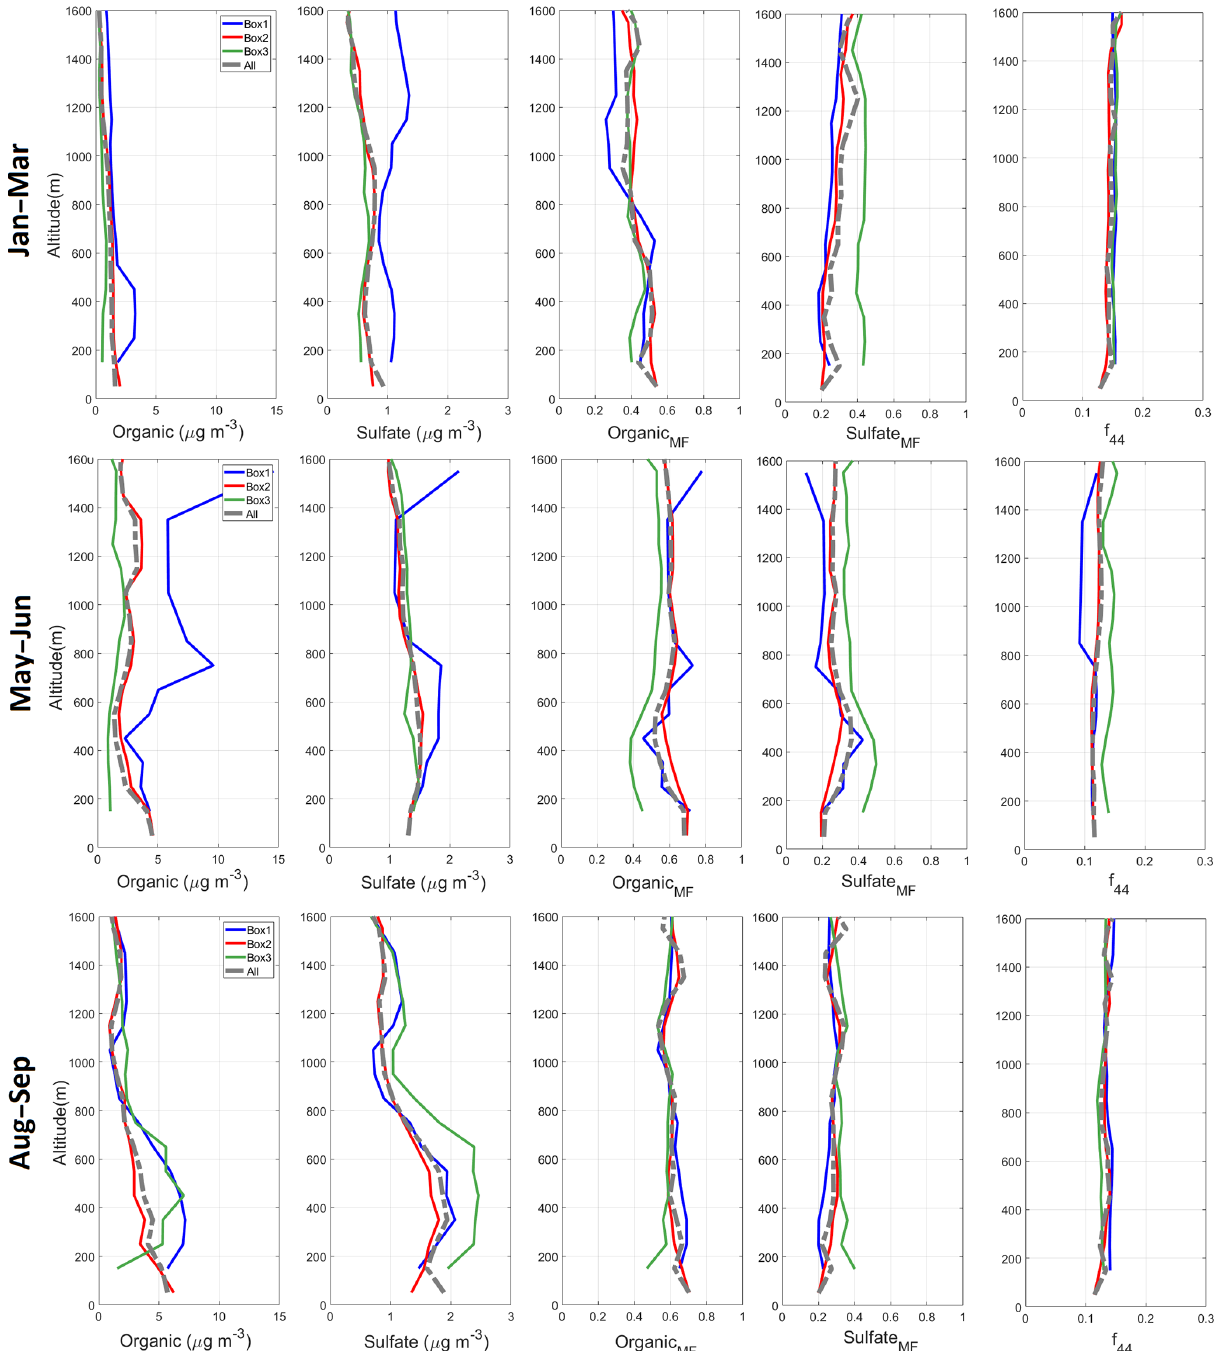
Figure 3. Vertically-resolved cloud-free AMS data for the different time periods of ACTIVATE deployments and boxes defined in Fig. 2a. Shown are (left to right) organic and sulfate concentrations, organic and sulfate mass fraction, and the ratio of m/z 44 to total organic ( f 44 ). The top row for January–March combines CAO and non-CAO days, which are separated for other parts of the study.